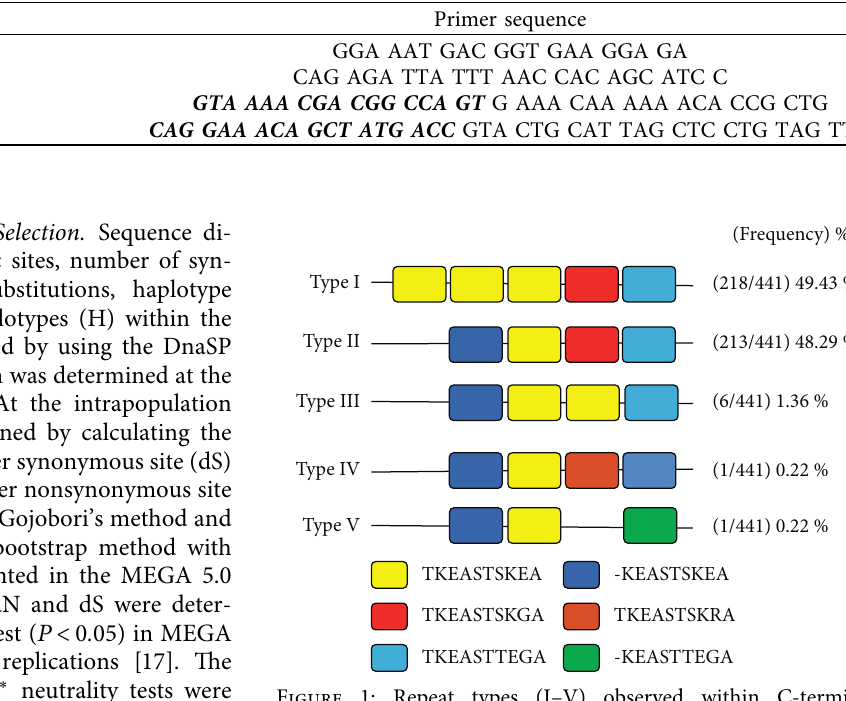
Table 1: Primers used for amplification and sequencing of PfKHARP gene.